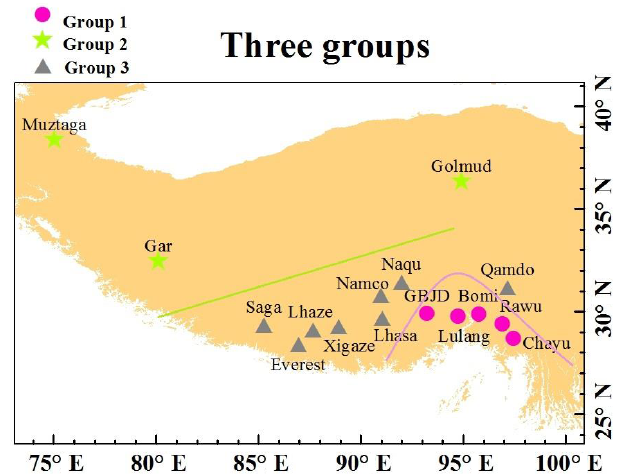
Figure 6. The geographic groups based on the cluster analysis (Group 1: monsoon region, Group 2: westerly region, Group 3: tran- sition